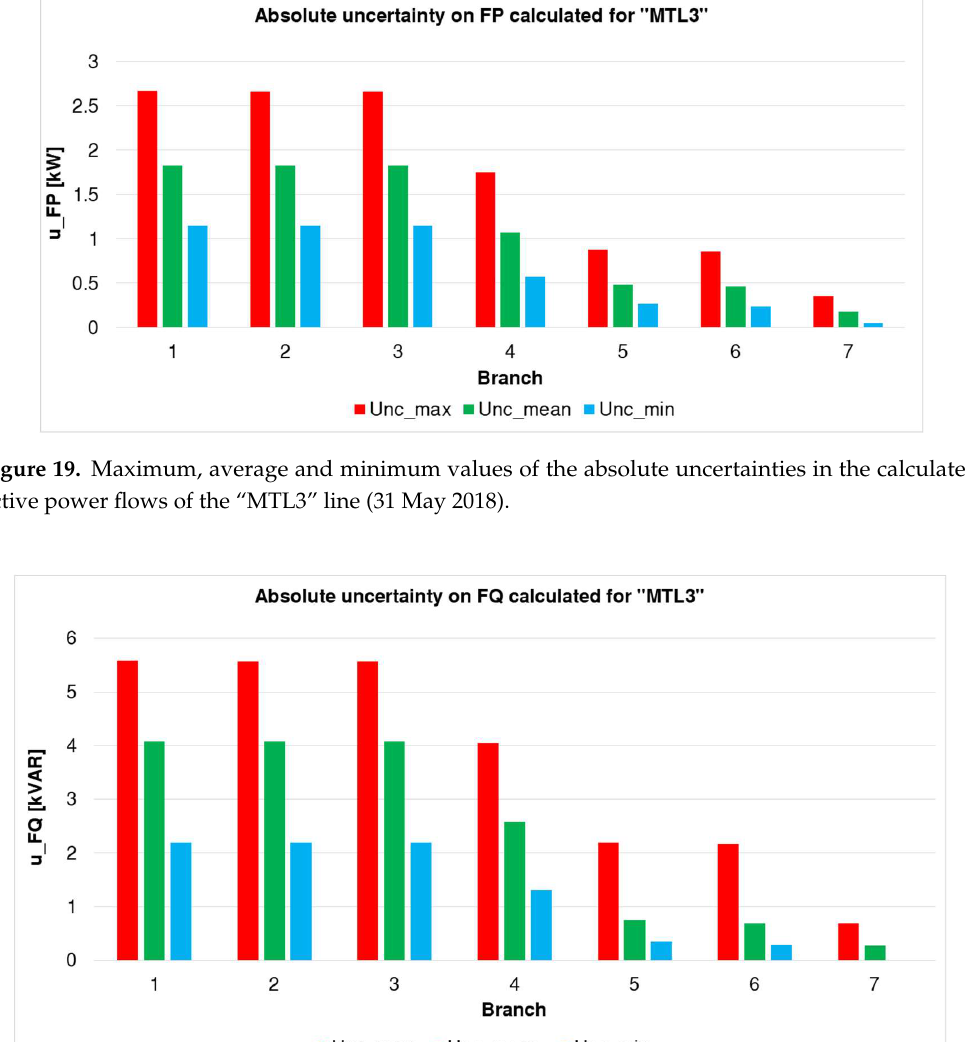
Figure 18. Maximum, average and minimum values of the relative uncertainties in the reactive power flows calculated of the “MTL2” line (31 May 2018).